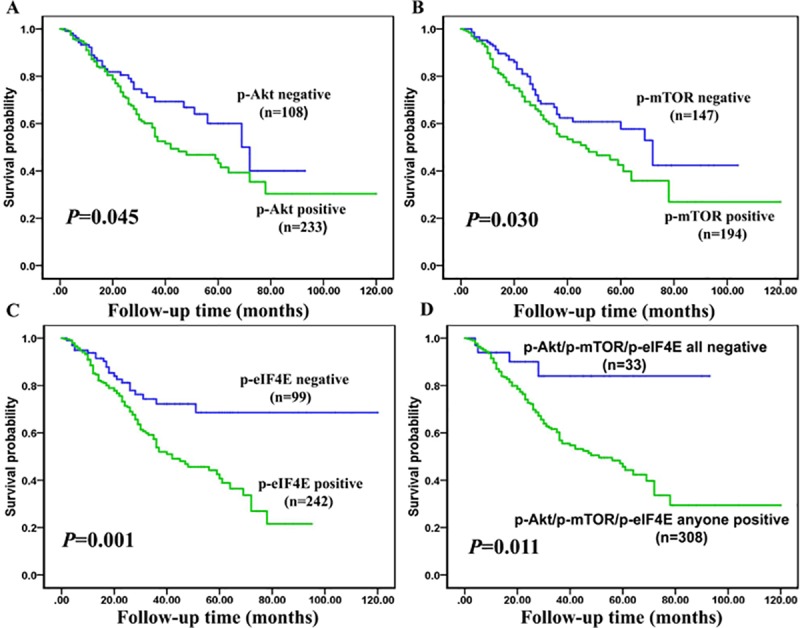
Kaplan-Meier analysis to plot the survival curve of NSCLC patients with expression of p-Akt, p-mTOR and p-eIF4E proteins and statistical significance were statistically evaluated by the log-rank test.Fig 3A: There was worse overall survival for NSCLC patients with p-Akt positive expression compared to patients with p-Akt negative staining (P = 0.045, two sided). Fig 3B: Result showed that statistically significant shorter overall survival for NSCLC patients with expression of p-mTOR protein compared to patients with p-mTOR negative expression (P = 0.030, two sided). Fig 3C: Kaplan-Meier curves indicated significantly shorter overall survival for NSCLC patients with expression of p-eIF4E compared to patients with negative expression of p-eIF4E (P = 0.001, two sided). Fig 3D: Kaplan-Meier curves also revealed worse overall survival for NSCLC patients with expression of any positive of p-Akt, p-mTOR and p-eIF4E proteins compared to patients with common negative staining of three proteins above (P = 0.011, two sided).